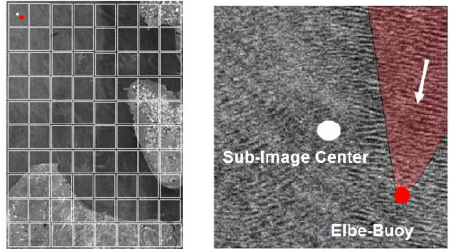
Figure 6. Uncertainties for comparison of TS-X derived sea state and buoy: TerraSAR-X Stripmap typical analysis with subscenes (left) and subscene with buoy (right); buoy represents statistics of a sector with sea state propagating to buoy (red marked area) integrated over time (typically 20min time